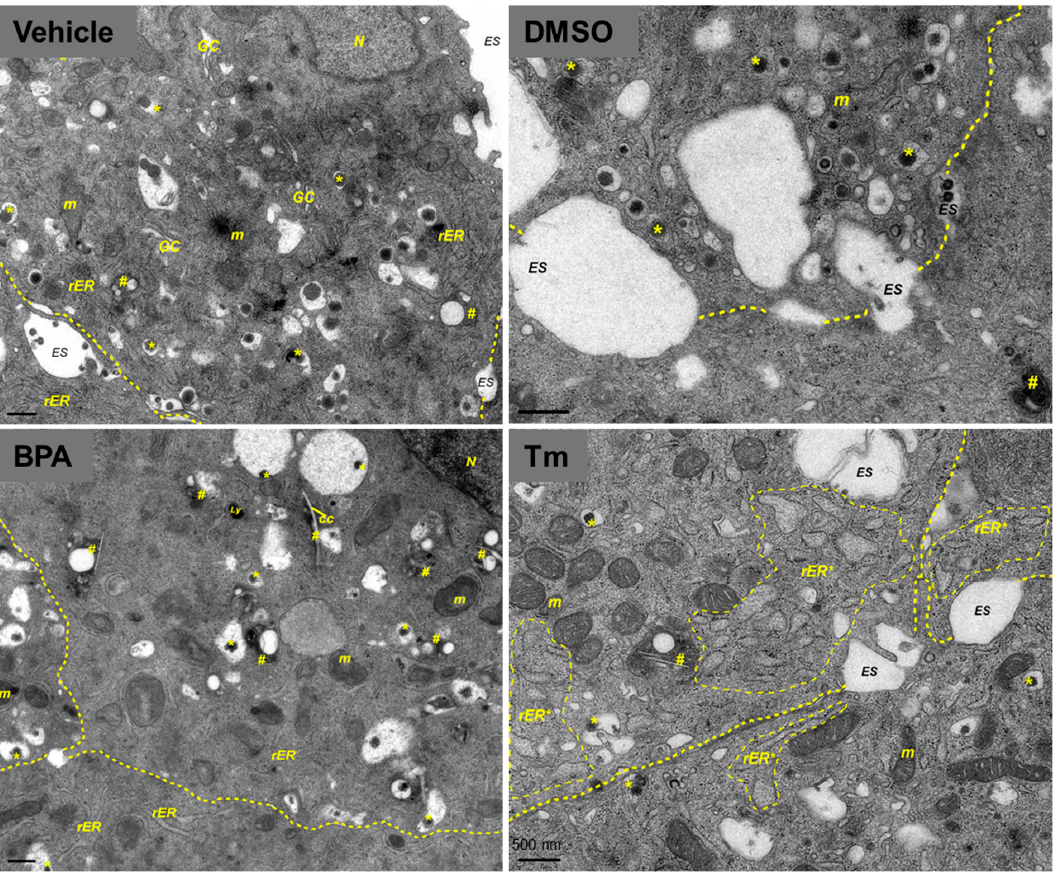
Figure 2. BPA exposure induces ultrastructural changes in MIN6 β -cells. Transmission electron microscopy images of MIN6 cells cultured for 24 h in the presence of vehicle for BPA (vehicle (ethanol), top left), 100 µM BPA (bottom left), a vehicle for Tm (DMSO, top right), and 5 µg/mL Tm (bottom right). Yellow dotted lines show boundaries between adjacent cells, while lighter yellow dashed lines indicate distended rough endoplasmic reticulum (rER). Insulin granules (*), autophagosomes (#). Note the abundant lipid-like droplets inside autolysosomes and the occurrence of cholesterol crystal (cc) clefts in BPA-exposed cells, suggestive of disturbed lipid metabolism after BPA exposure. The scale bar is 500 nm. N , nucleus; m , mitochondria ; Ly , lysosomes; ES , extracellular space.